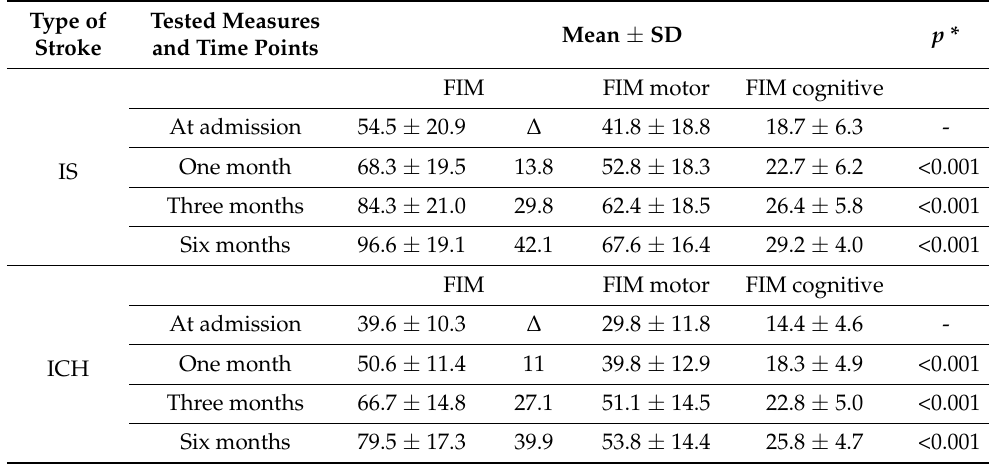
Table 5. Results of analyses for related samples and descriptive statistics of motor and cognitive FIM subscale and EQ-5D-3L in relation to the type of